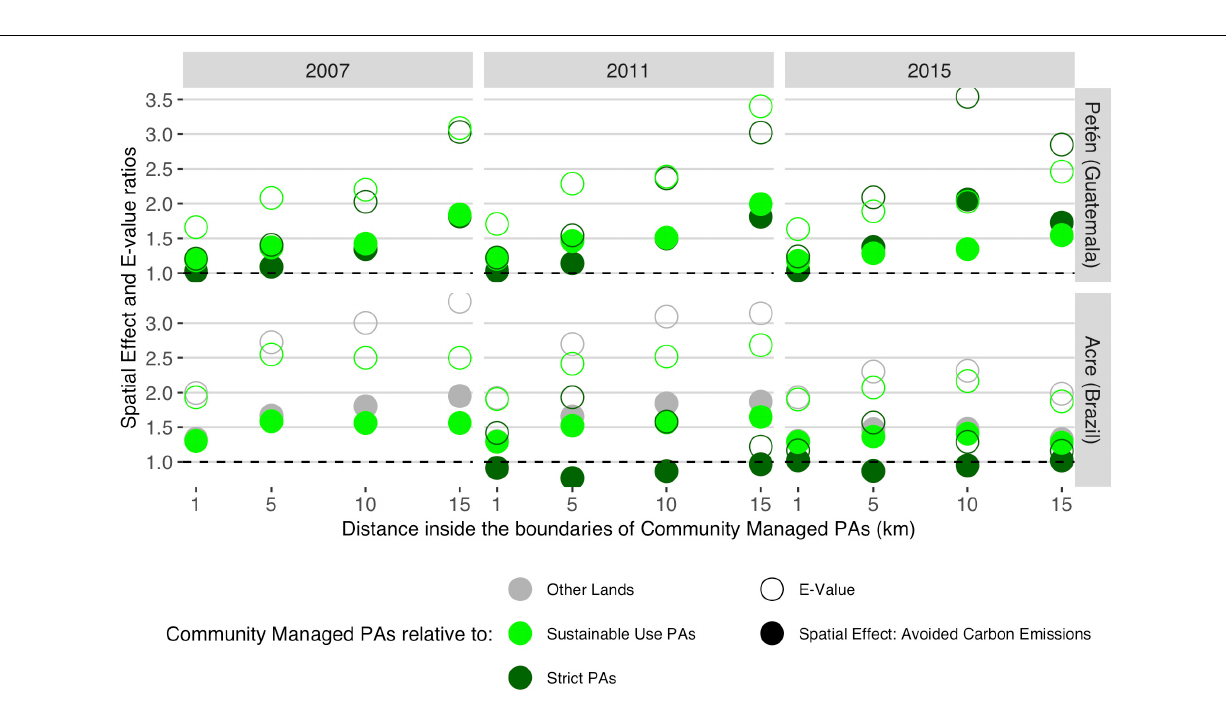
Frontiers in Forests and Global Change |